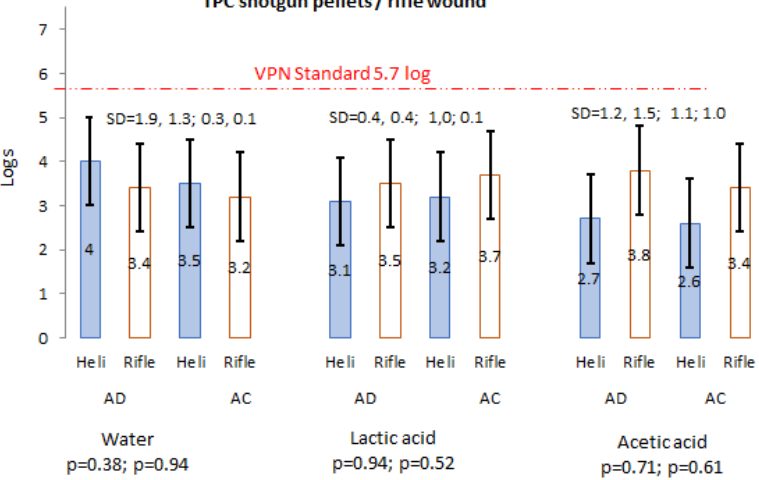
Figure 2. Average log counts of TPC helicopter and rifle wounds before and after water, LA and AA treatment.